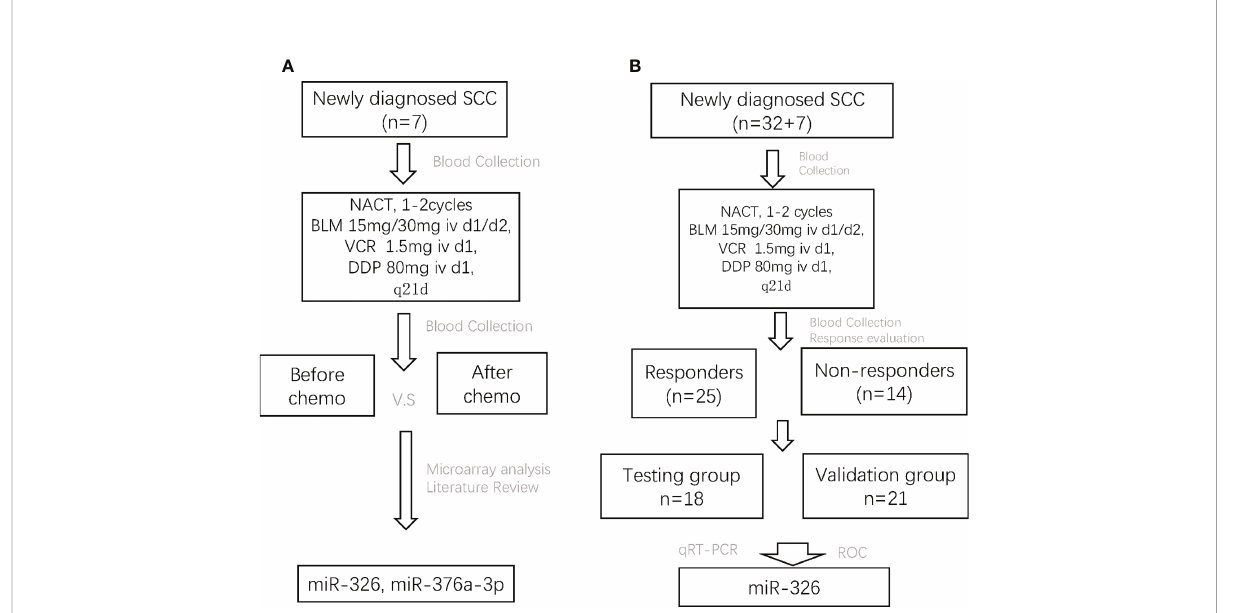
FIGURE 1 The fl owchart of the whole study design. SCC, squamous cell carcinoma; NACT, neoadjuvant chemotherapy; BLM, bleomycin; VCR, vincristine; DDP, cisplatin; CR, complete response; PR, partial response; SD, stable disease; PD, progressive